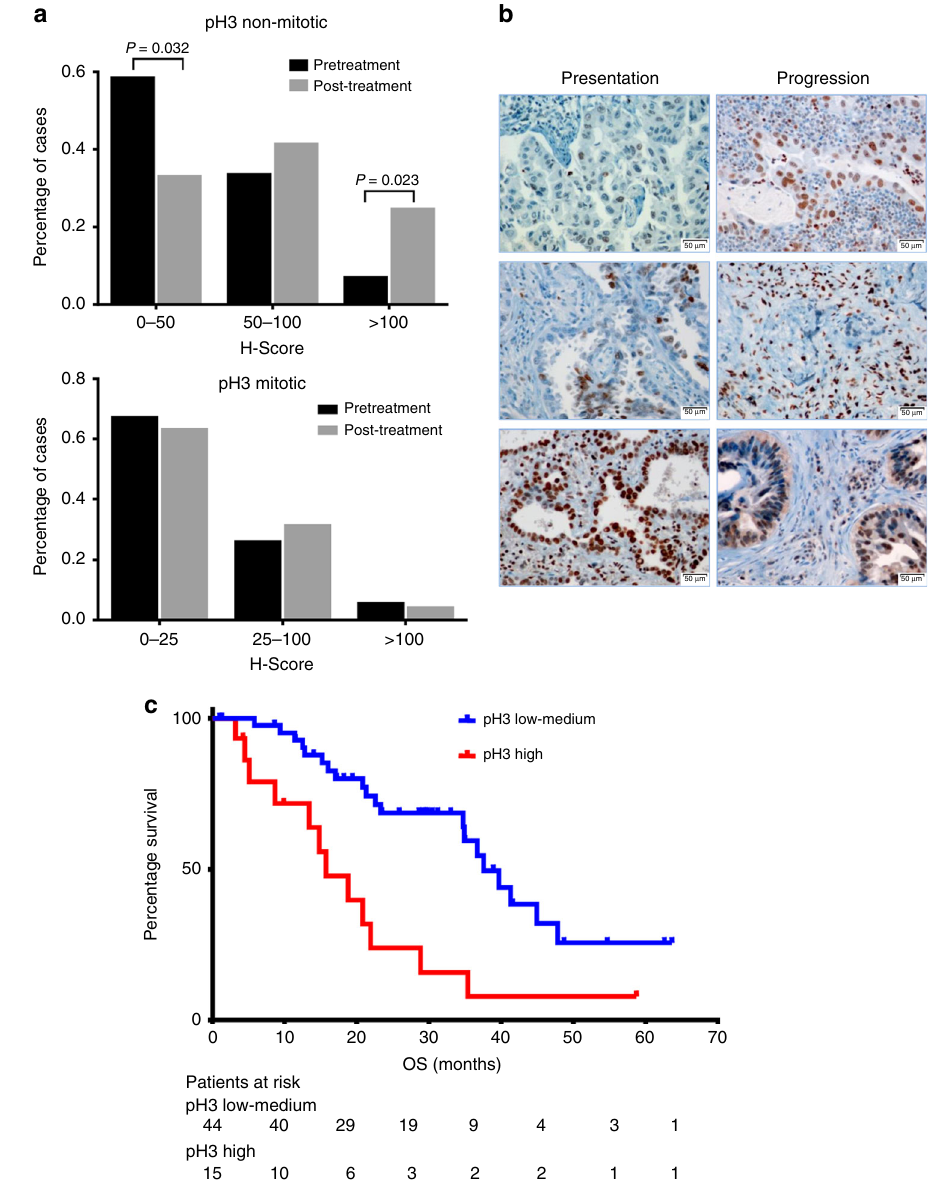
Fig. 6 pH3 in EGFR -mut NSCLC patients. a H-scores of non-mitotic (upper panel) and mitotic pH3 (lower panel) and in samples from EGFR-mut NSCLC patients baseline ( n = 68, black bars) and after progression to EGFR TKIs ( n = 24, gray bars). H-scores of every tumor were evaluated independently by two expert pathologists ( n = 2). Numbers indicate levels of signi fi cance ( p ) in a Z score test. b IHC staining of pH3 of representative tumors at presentation and after progression to EGFR TKIs. Scale bars indicate 50 μ m. c OS according to overall pH3 H-score at presentation in 59 EGFR -mut NSCLC patients treated with fi rst-line EGFR TKIs. Median OS was 15.7 (CI 95% = 8.9 – 22.5) months for the 15 patients with high pH3 (Q4, red line) vs. 37.6 months